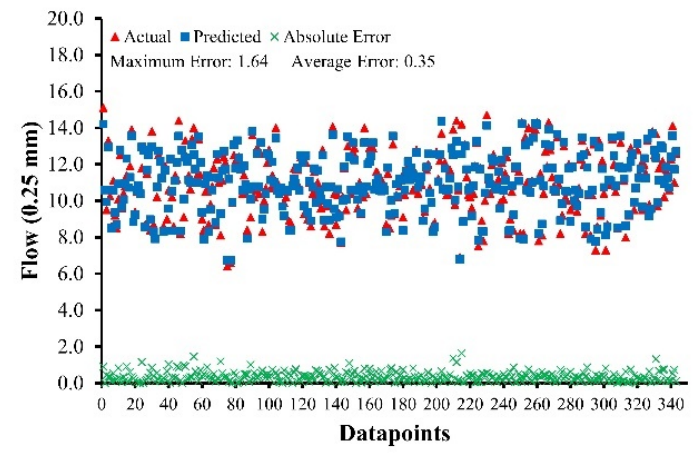
Figure 8. Absolute errors of AWC–MF.